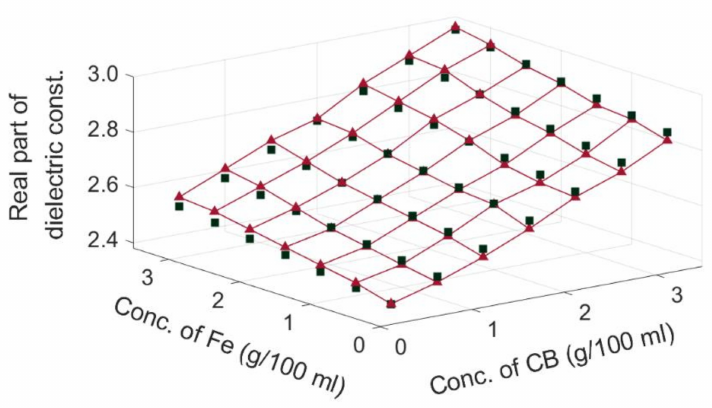
Figure 12. Comparison between the EMT results (green marks) and the experimental results (red marks) for the real part of equivalent relative